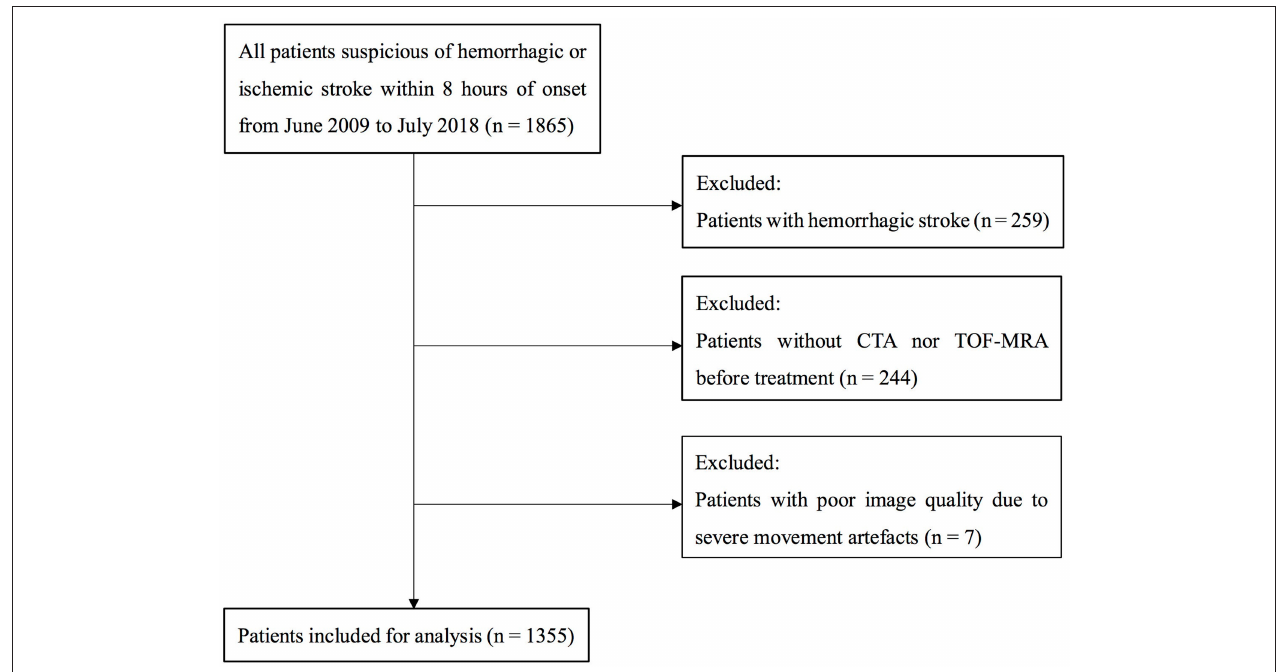
FIGURE 1 | Flow chart of patient selection. CTA indicates CT angiography; and TOF-MRA, time of flight MR